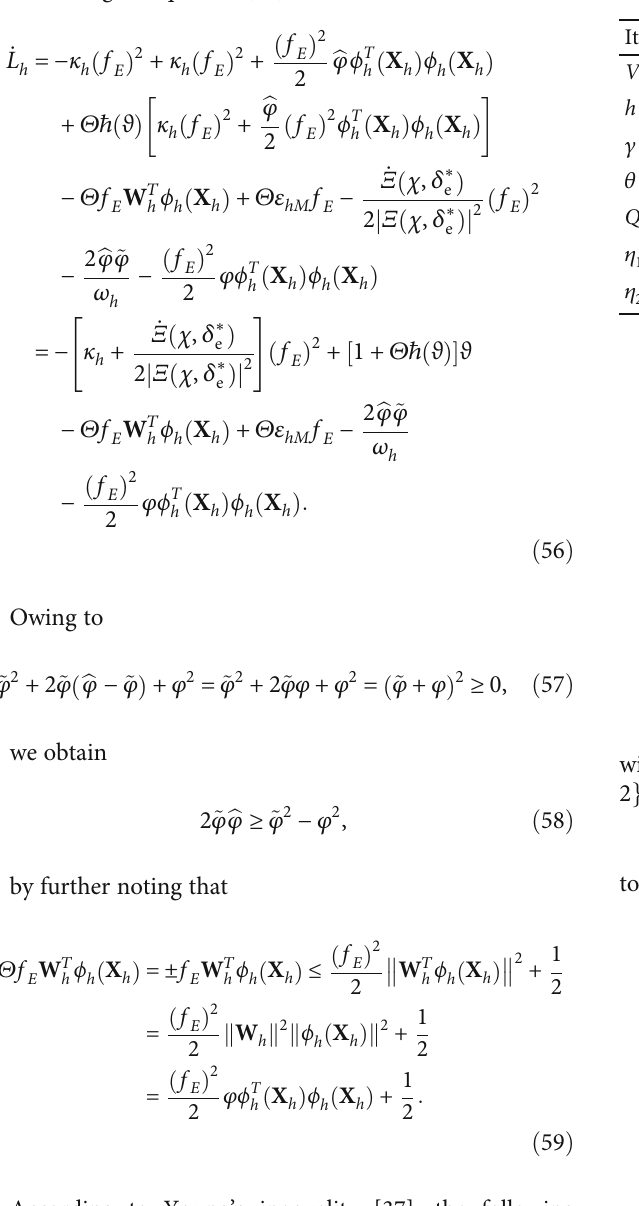
Table 1: Initial trim